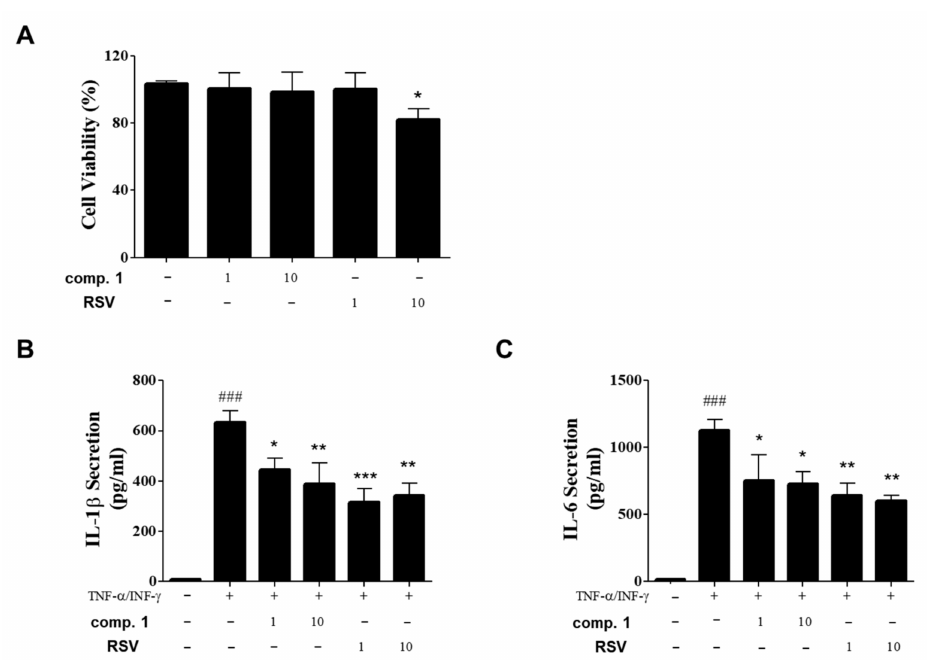
Figure 5. Inhibitory effects of resvebassianol A on the inflammatory cytokine expression of TNF- α /INF- γ -induced HIEC-6 cells. ( A ) Cells were cultured in 96-well plates, and they were treated with resvebassianol A and RSV at 1 and 10 µ M, respectively. After 24 h, cell viability was measured using the MTT assay. ( B , C ) The levels of IL-6 and IL-1 β in the supernatants were determined using ELISA. Values are expressed as means ± SD. ### p < 0.001 versus control group; * p < 0.05, ** p < 0.01, and *** p < 0.001 vs. TNF- α /IFN- γ -treated